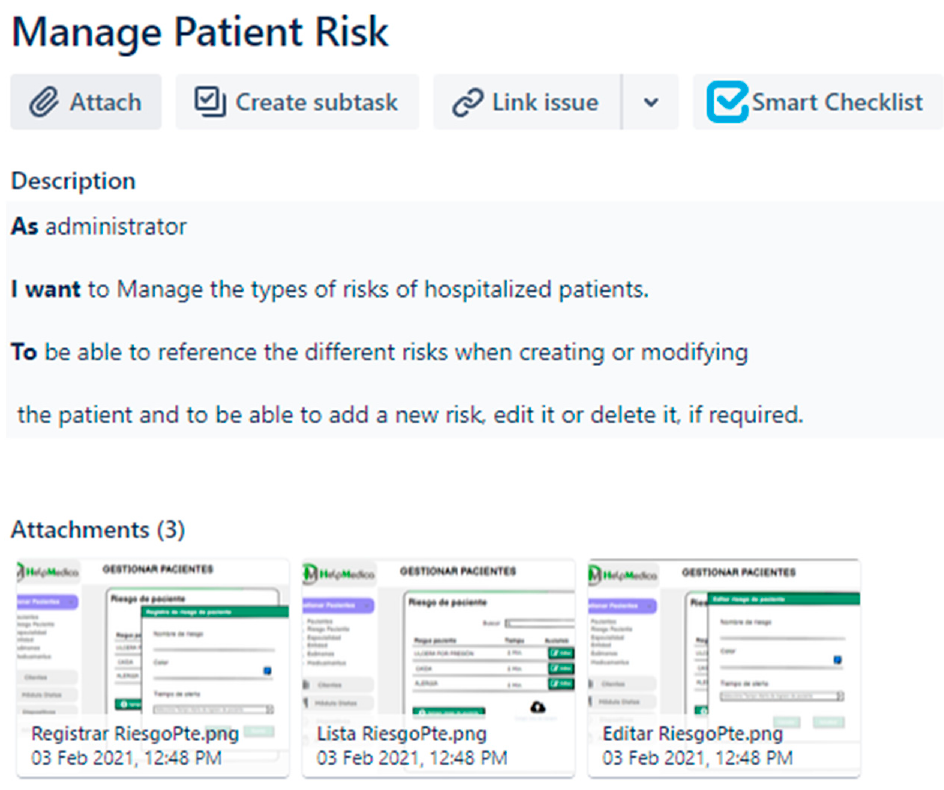
Figure 4. JIRA User Stories—Manage Patient Risk.